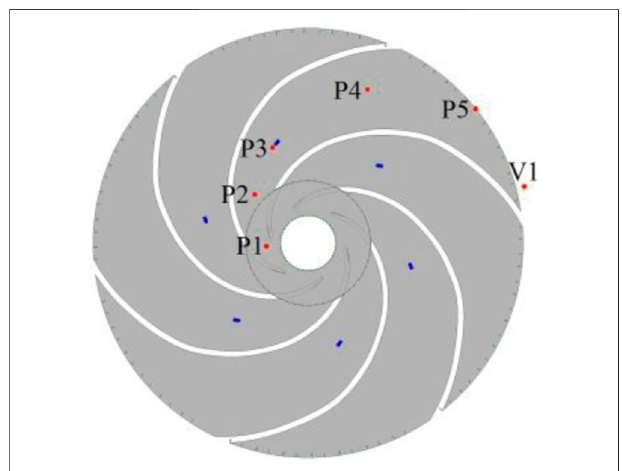
FIGURE14 | Monitoring points in the impeller middle